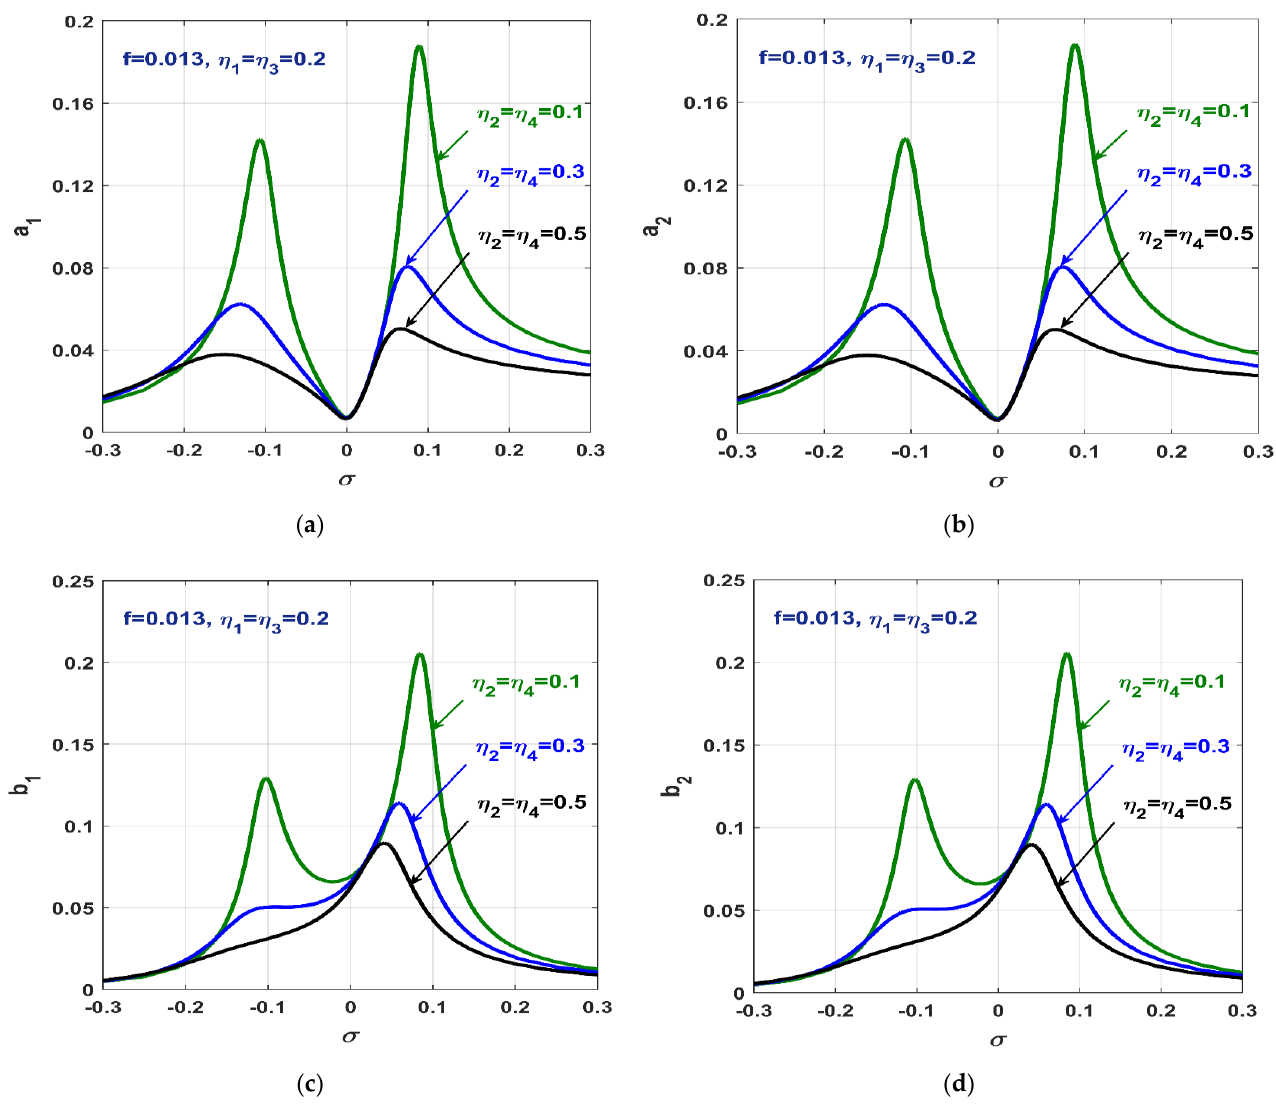
Figure 9. Vibration amplitudes of the twelve-poles rotor in the case of the PD + IRC + PPF -control algorithm at f = 0.013, η 1 = η 3 = 0.2, when η 2 = η 4 = 0.1, 0.3, and 0.5: ( a , b ) vibration amplitudes ( a 1 , a 2 ) of the rotor, and ( c , d ) vibration amplitudes ( b 1 , b 2 ) of the PPF